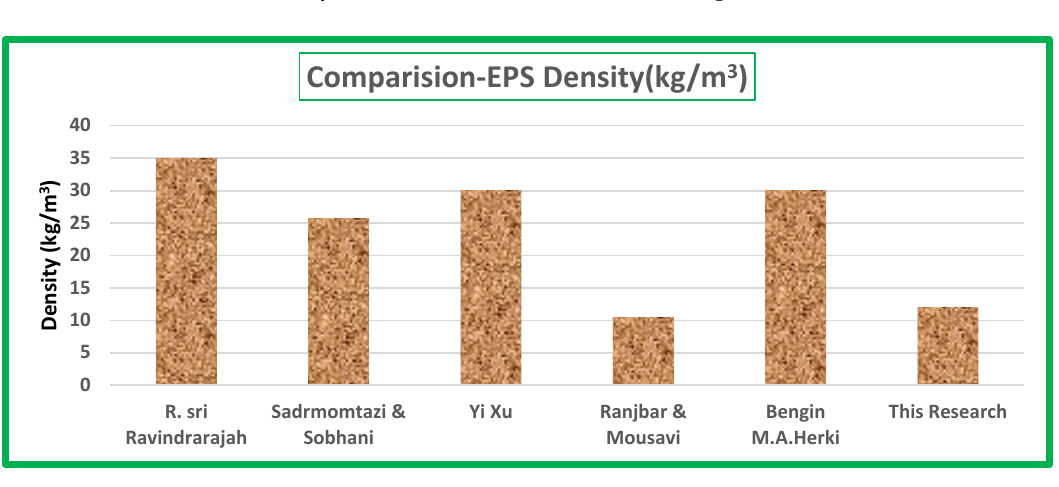
Figure 9. Comparative analysis of EPS-beads density of this study with Ravindrarajah, R. Sri [59], Sadrmomtazi, A., et al. [60], Xu, Yi, et al. [6], Ranjbar, M.M., and Mousavi, S.Y. [61], and Herki, B. [2]. Figure 10 indicates the EPS-beads concrete density of different previous research that clearly indicates that the density of concrete is dependent on the dosage of EPS-beads.